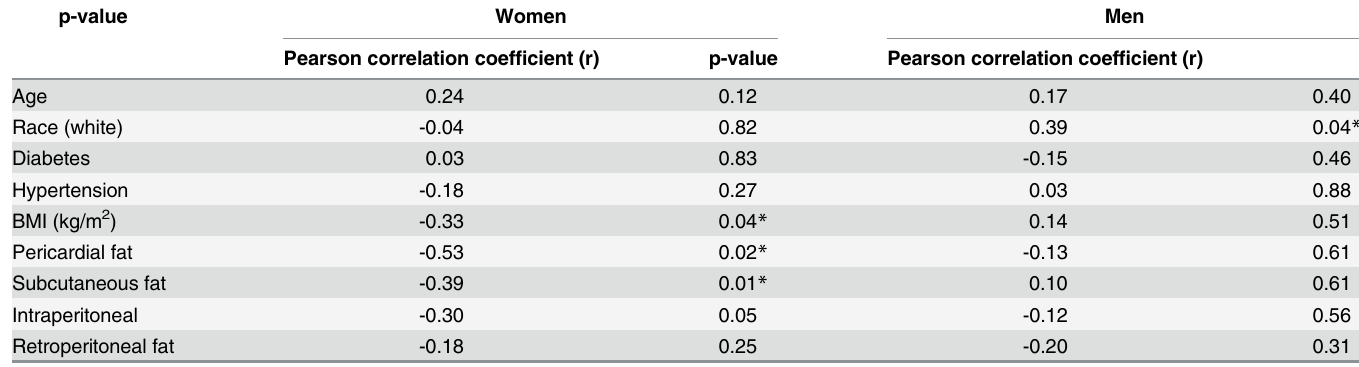
Table 4. Sex-specific correlations between covariates and myocardial perfusion index at peak dose dobutamine.